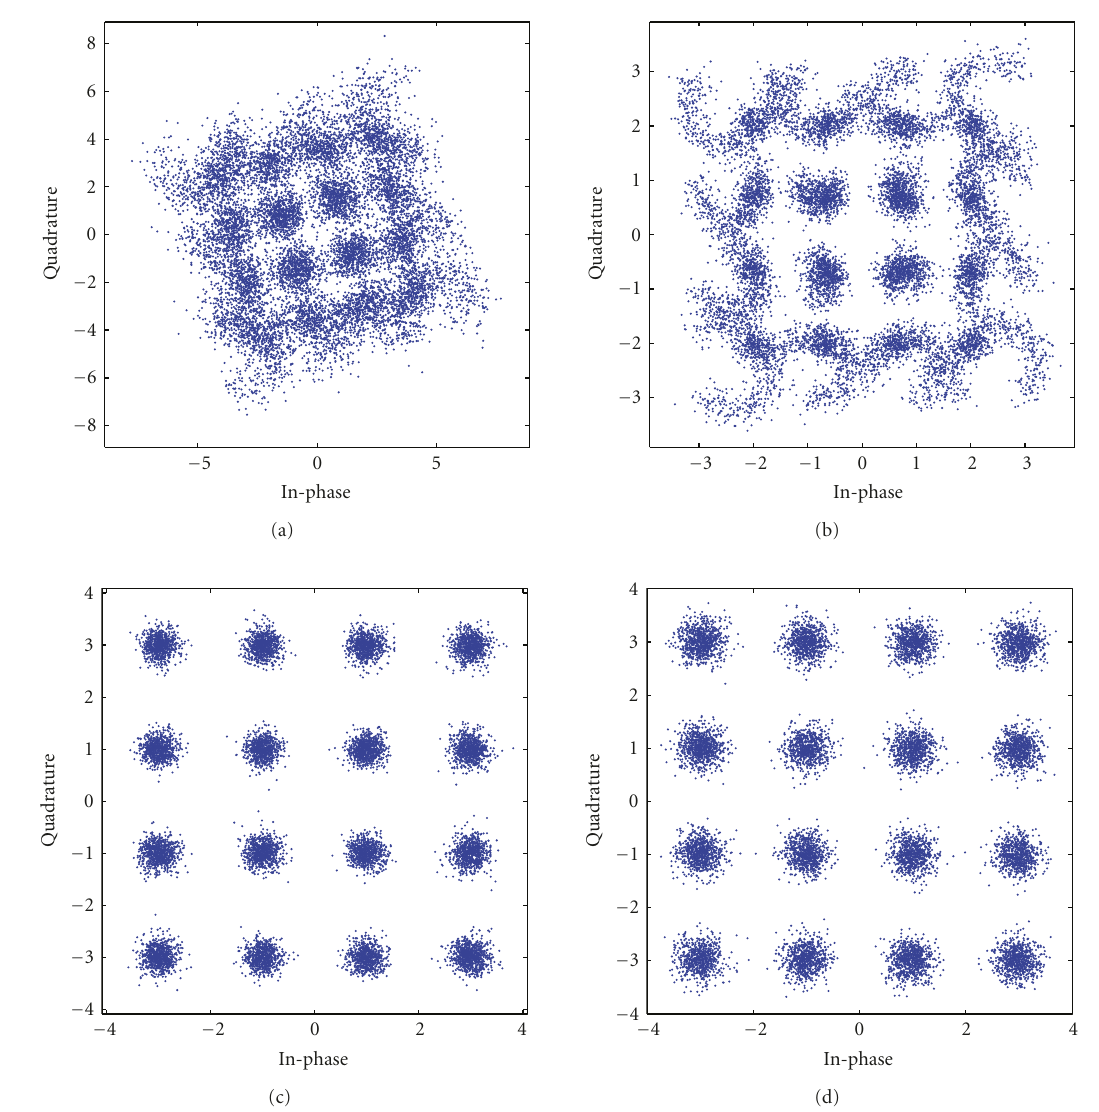
Figure 25: Constellation of received signal at IBO = 7dB and SNR = 20 dB: (a) polluted by HPA, (b) memoryless NN PD, (c) LN-NLN PD, (d) FCNN PD.